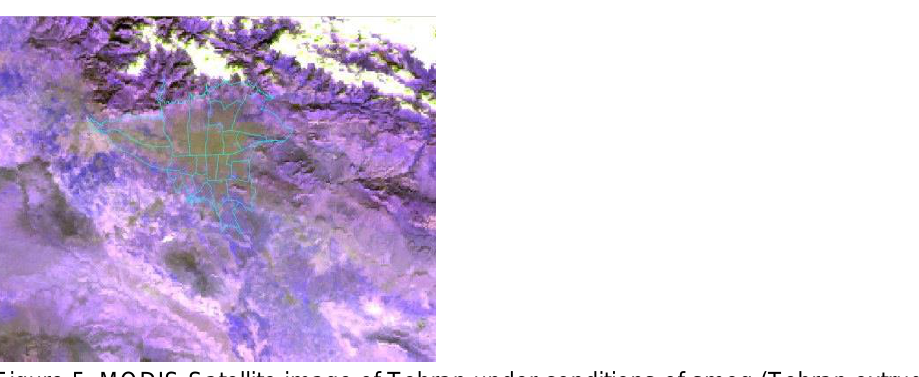
Figure 5. MODIS Satellite image of Tehran under conditions of smog (Tehran extruded in post) This satellite image is a MODIS (Moderate Resolution Imaging Spectroradiometer) image released to